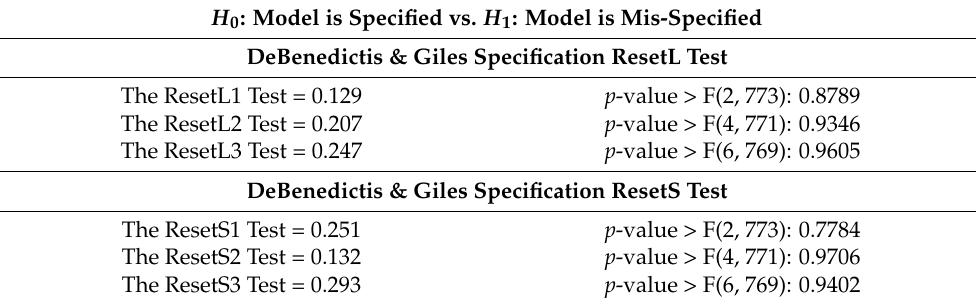
Table 5. DeBenedictis and Giles (1998) Specification RESET Tests.